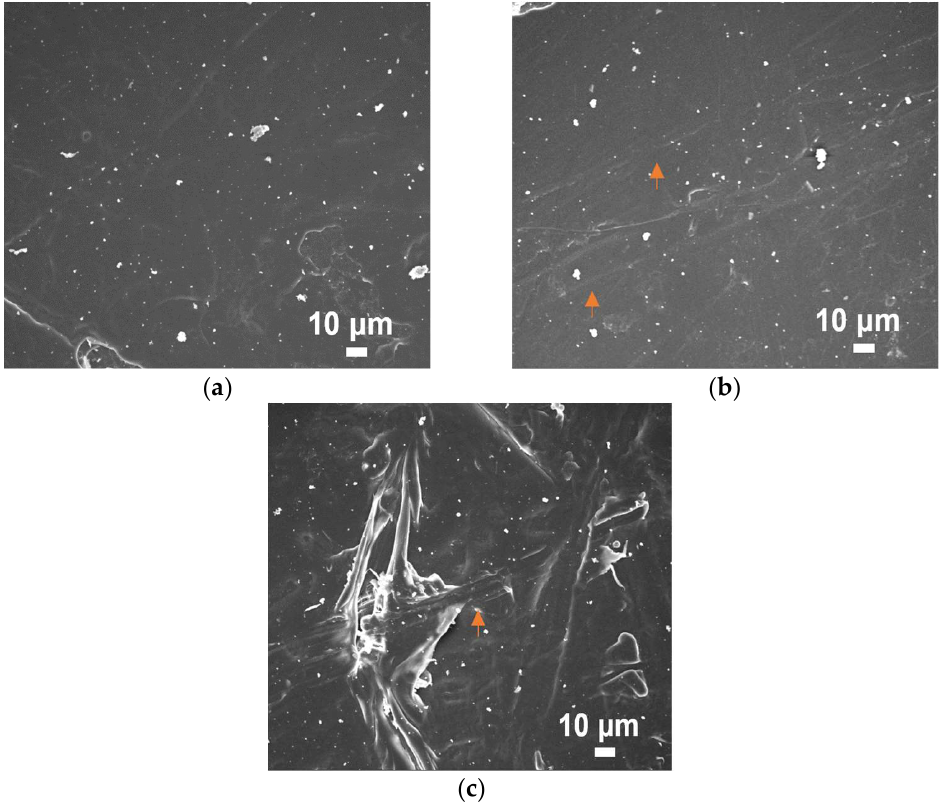
Figure 9. Microphotographs of ( a ) recycled high-density polyethylene (r-HDPE), and r-HDPE + ( b ) 20% wt. and ( c ) 50% wt. hemp fibers (HF) composite materials. Magnification ×500.